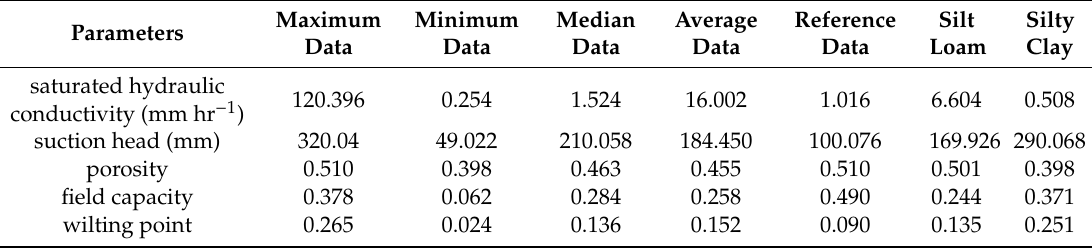
Table 2. Reference values of 5 soil parameters for sensitivity